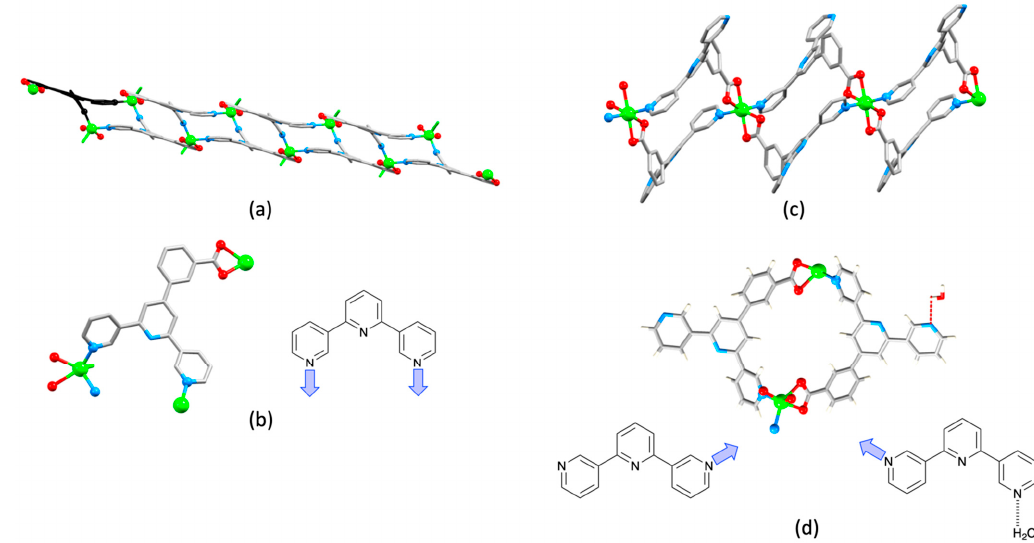
Figure 41. ( a ) Part of the ‘double-decker’ 2D-network in [ZnCl( 62 )] n (CSD refcode IKEXED); one 62 – ligand is shown in Figure 41. (a) Part of the ‘double ‐ decker’ 2D ‐ network in [ZnCl( 62 )] n (CSD refcode IKEXED); one 62 – ligand is shown in black to emphasize the conformation of the ligand. (b) The building block in [ZnCl( 62 )] n and the planar conformation of black to emphasize the conformation of the ligand. ( b ) The building block in [ZnCl( 62 )] n and the planar conformation of the 3,2’:6’,3” ‐ tpy unit. (c) Part of the loop ‐ like 1D ‐ polymer in [Zn( 62 ) 2 ] n . 2 n H 2 O (refcode IKEXIH), and (d) detail of one loop the 3,2 (cid:48) :6 (cid:48) ,3 (cid:48)(cid:48) -tpy unit. ( c ) Part of the loop-like 1D-polymer in [Zn( 62 ) 2 ] n · 2 n H 2 O (refcode IKEXIH), and ( d ) detail of one in the chain showing two different ligand conformations; one non ‐ coordinated pyridine ring is involved in hydrogen bond loop in the chain showing two different ligand conformations; one non-coordinated pyridine ring is involved in hydrogen formation. bond